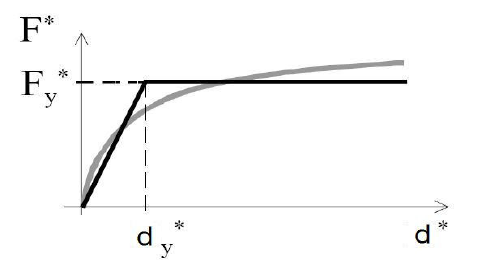
Fig. 10. SDOF capacity curve and its bi